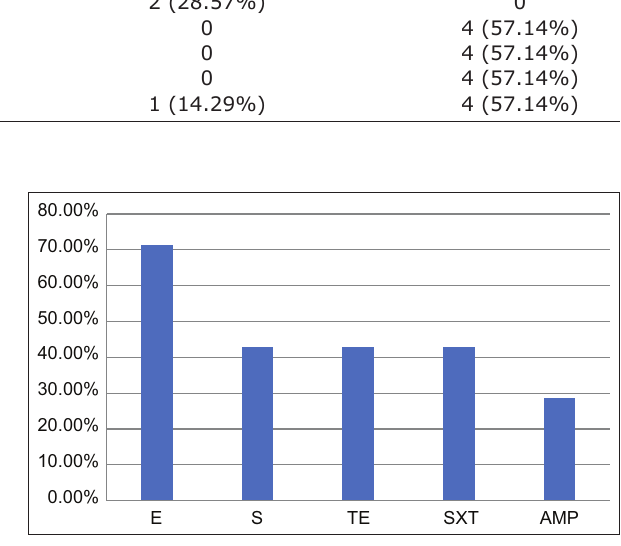
Table-2: Antibiotic susceptibility profile of C. freundii isolated from laying chickens in Blitar, Indonesia. Antibiotic